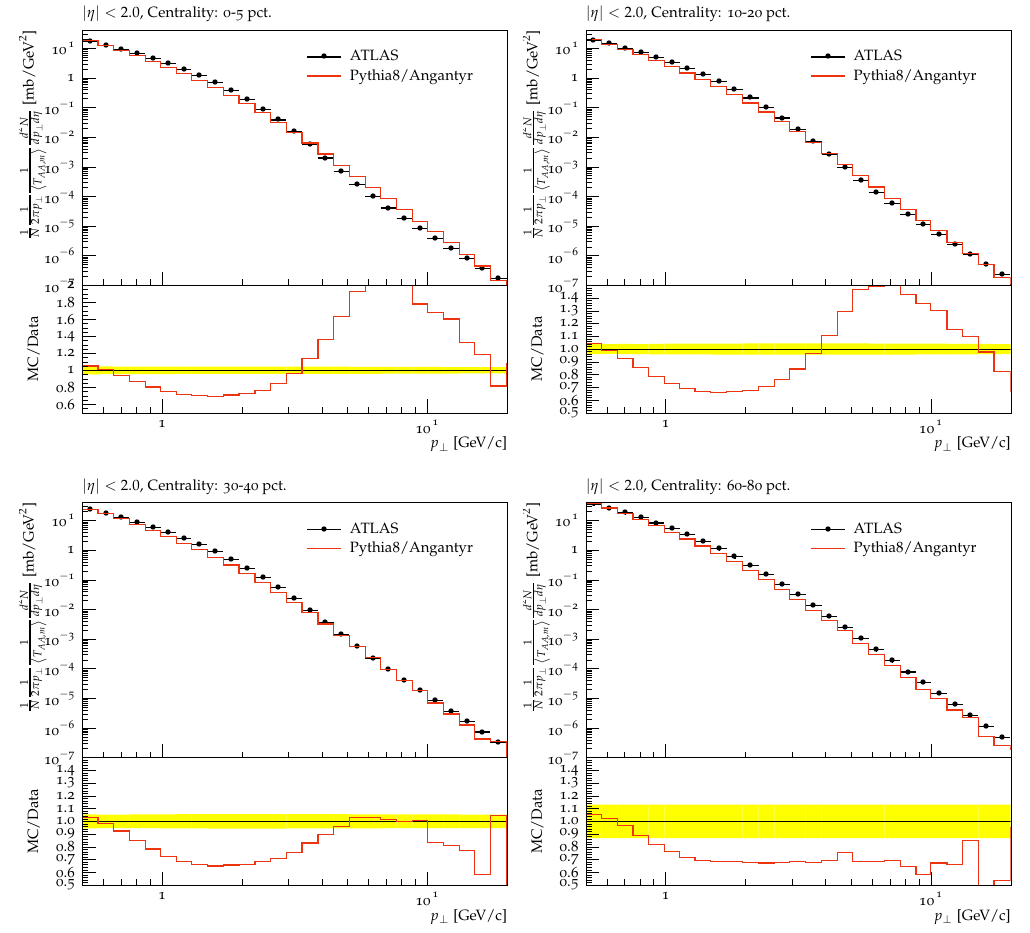
Figure 18 . Transverse momentum distributions of charged particles in PbPb collisions at p s 2 : 76 TeV in four centrality bins, compared to Angantyr. Data from ATLAS [59]. point for improvement of the underlying model for soft particle production, also in